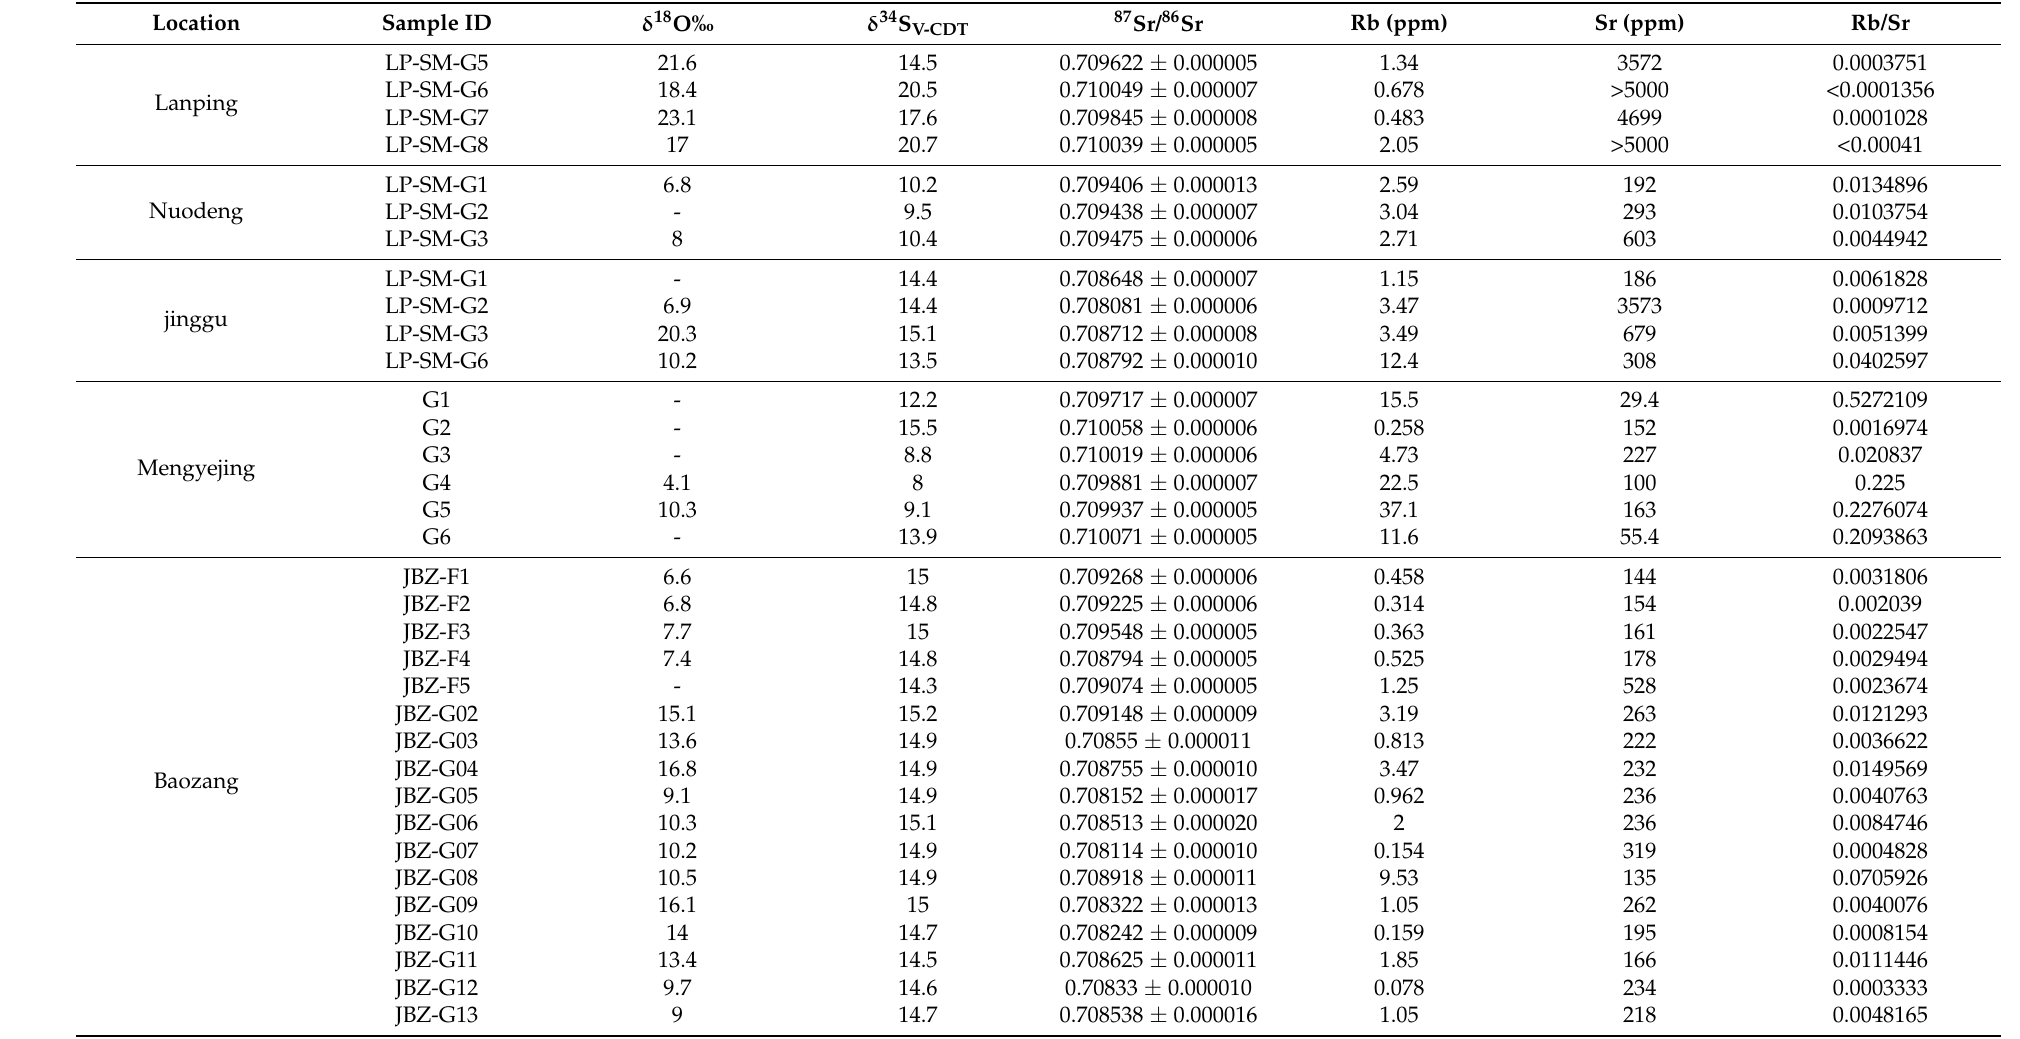
Table 2. Sr, S, and O isotope compositions of evaporite samples within the Lanping–Simao